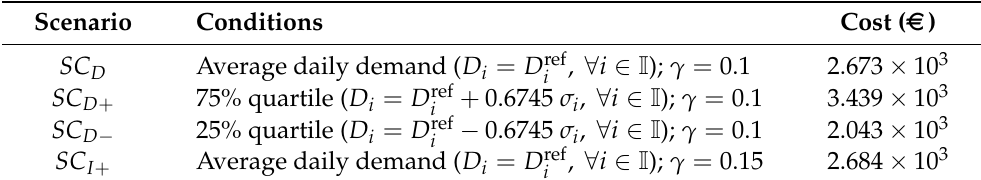
Figure 5. Assignment of batches to week days for deterministic (and stochastic) consumption without inventory control. Table 2. Overall optimal cost for 28d production horizon.